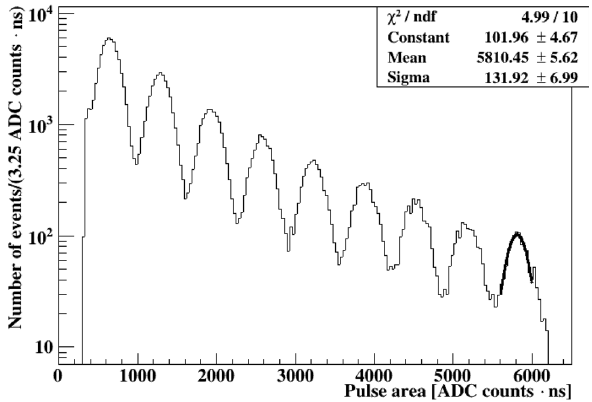
Fig. 6 Single PE response of the top SiPM in logarithm scale. The ones from the bottom SiPM are very